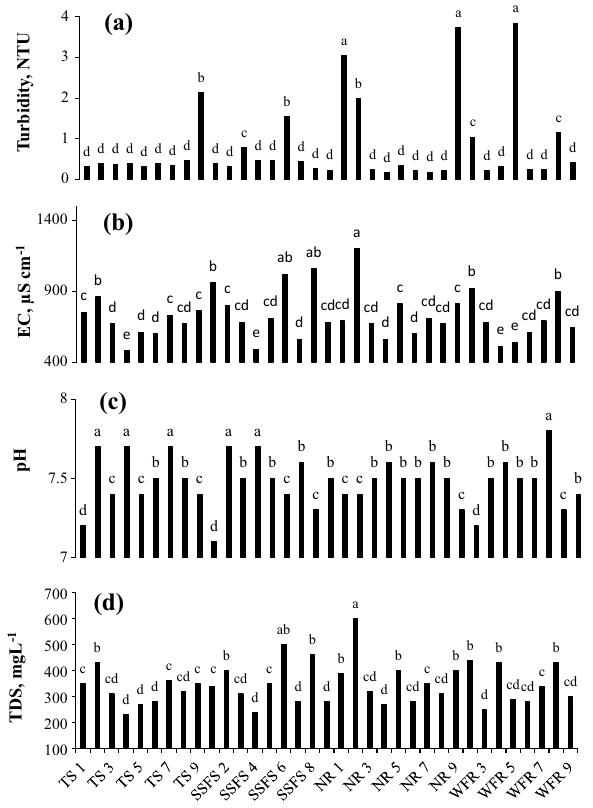
Fig. 2 Some parameters determined in water samples. a Turbidity, b EC = Electrical Conductivity, c pH and d TDS = Total Dissolved Solids at different sources of food stalls. NR = Normal Restaurants, TS = Tea Stalls, SSFS = Street Side Fast Food Stalls and WFR = Well- furnished Restaurants. Bars with different letters are significantly dif- ferent ( p < 0.05) according to a Ryan–Einot–Gabriel–Welsch multiple range